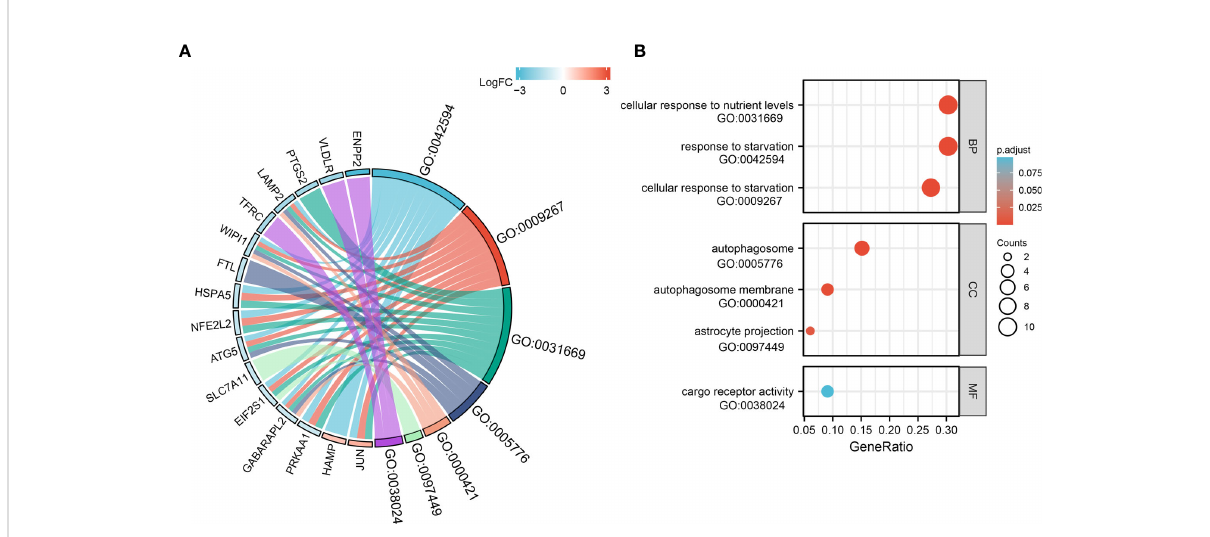
FIGURE 5 Gene Ontology (GO) functional analysis of 33 ferroptosis-related DE-mRNAs. Chord (A) and Bubble plot (B) of enriched GO terms of 33 ferroptosis-related DE-mRNAs. Y-axis: name of GO items; X-axis: percentage of the number of genes assigned to a term among the total number of genes annotated in the network; Bubble size, number of genes assigned to a pathway; Color: enriched -log10( P -value); Red bubble: indicates a greater signi fi cance level.